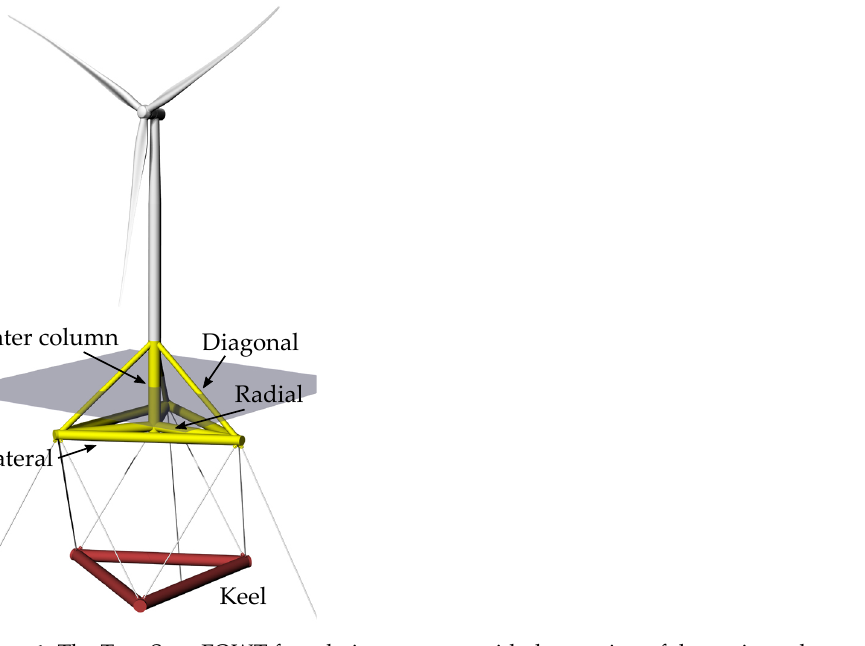
Figure 1. The TetraSpar FOWT foundation concept, with the naming of the various